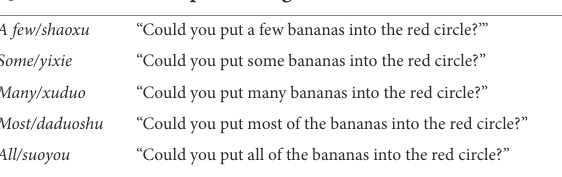
TABLE 1 Examples of how quantifiers were used in the give-quantifier task.